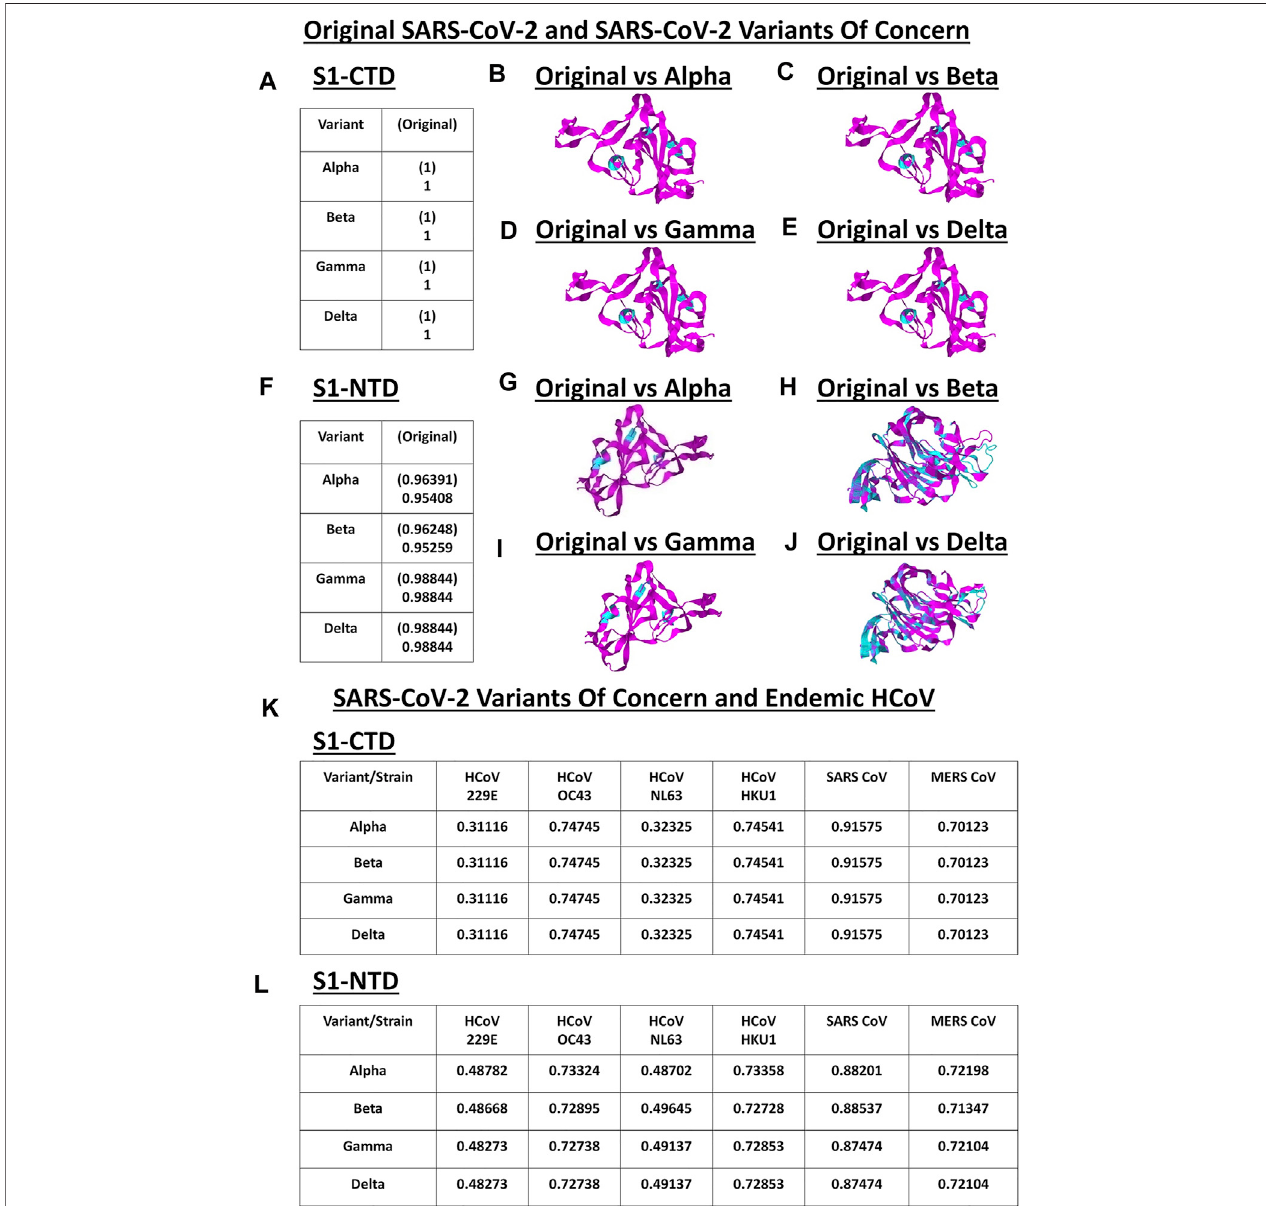
FIGURE 4 | Structural comparison of the VOC spike models relative to the original SARS2 and endemic HCoV based on S1-CTD and S1-NTD models. (A – J) Original SARS2 and VOC. (A) TM scores of superimposed S1-CTD models. TM scores normalized to a spike model are distinguished by the presence (original SARS2) or absence (VOC) of a parenthesis. Structural superimposition of SARS2 S1-CTD models between (B) original SARS2 and alpha variant (C) original SARS2 and beta variant (D) original SARS2 and gamma variant, and (E) original SARS2 and delta variant are shown. (F) TM scores of superimposed S1-NTD models. TM scores normalizedtoaspikemodelaredistinguishedbythepresence(originalSARS2)orabsence(VOC)ofaparenthesis.StructuralsuperimpositionofSARS2S1-NTDmodels between (G) original SARS2 and alpha variant (H) original SARS2 and beta variant (I) original SARS2 and gamma variant, and (J) original SARS2 and delta variant are shown.OriginalSARS2 iscoloredmagentawhile theVOC iscoloredcyan. (K – L) VOCand endemicHCoV. (K) TMscoresofsuperimposed S1-CTDmodels. TMscores normalizedtoVOC models. (L) TMscoresofsuperimposed S1-NTD models.TMscoresnormalizedtoVOC models.Endemic HCoVs[HCoV 229E (229E), HCoVOC43 (OC43), HCoV NL63 (NL63), HCoV HKU1 (HKU1), SARS-CoV-1 (SARS1), and MERS CoV (MERS)] are indicated.